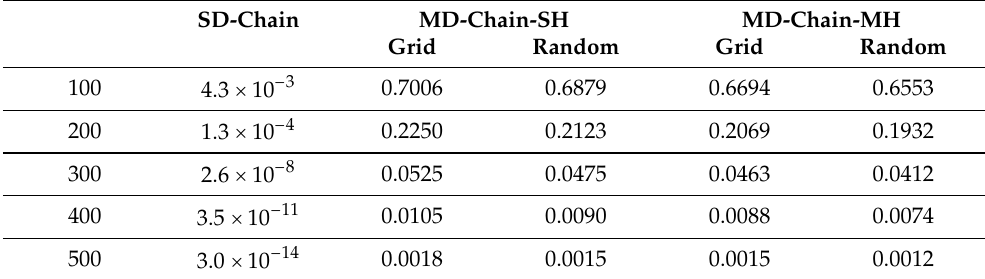
Table 2. Comparison of D-Chain models.